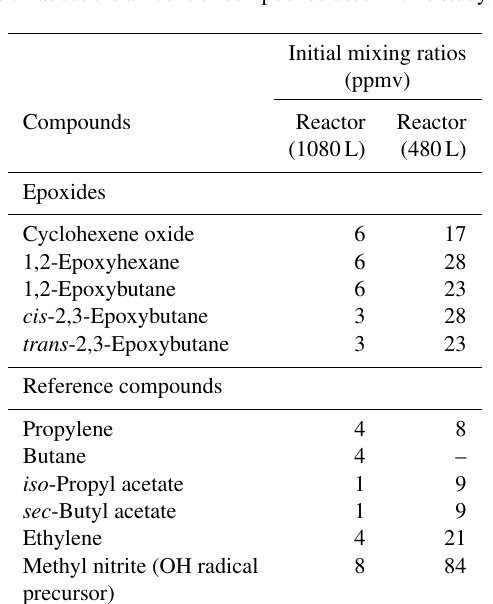
Table 1. Initial mixing ratios used in the 1080L reactor and 480L reactor for the epoxide and reference compounds in parts per million by volume (ppmv; 1ppm = 2.46 × 10 13 moleculecm − 3 ) at (298 ± 3)K and (760 ± 10)Torr ((1.01 ± 0.01) × 10 5 Pa) of total pressure of air. The mixing ratios have been estimated from injec- tions of the compounds into the reaction chambers and provide in- formation about the amount of compounds used in this